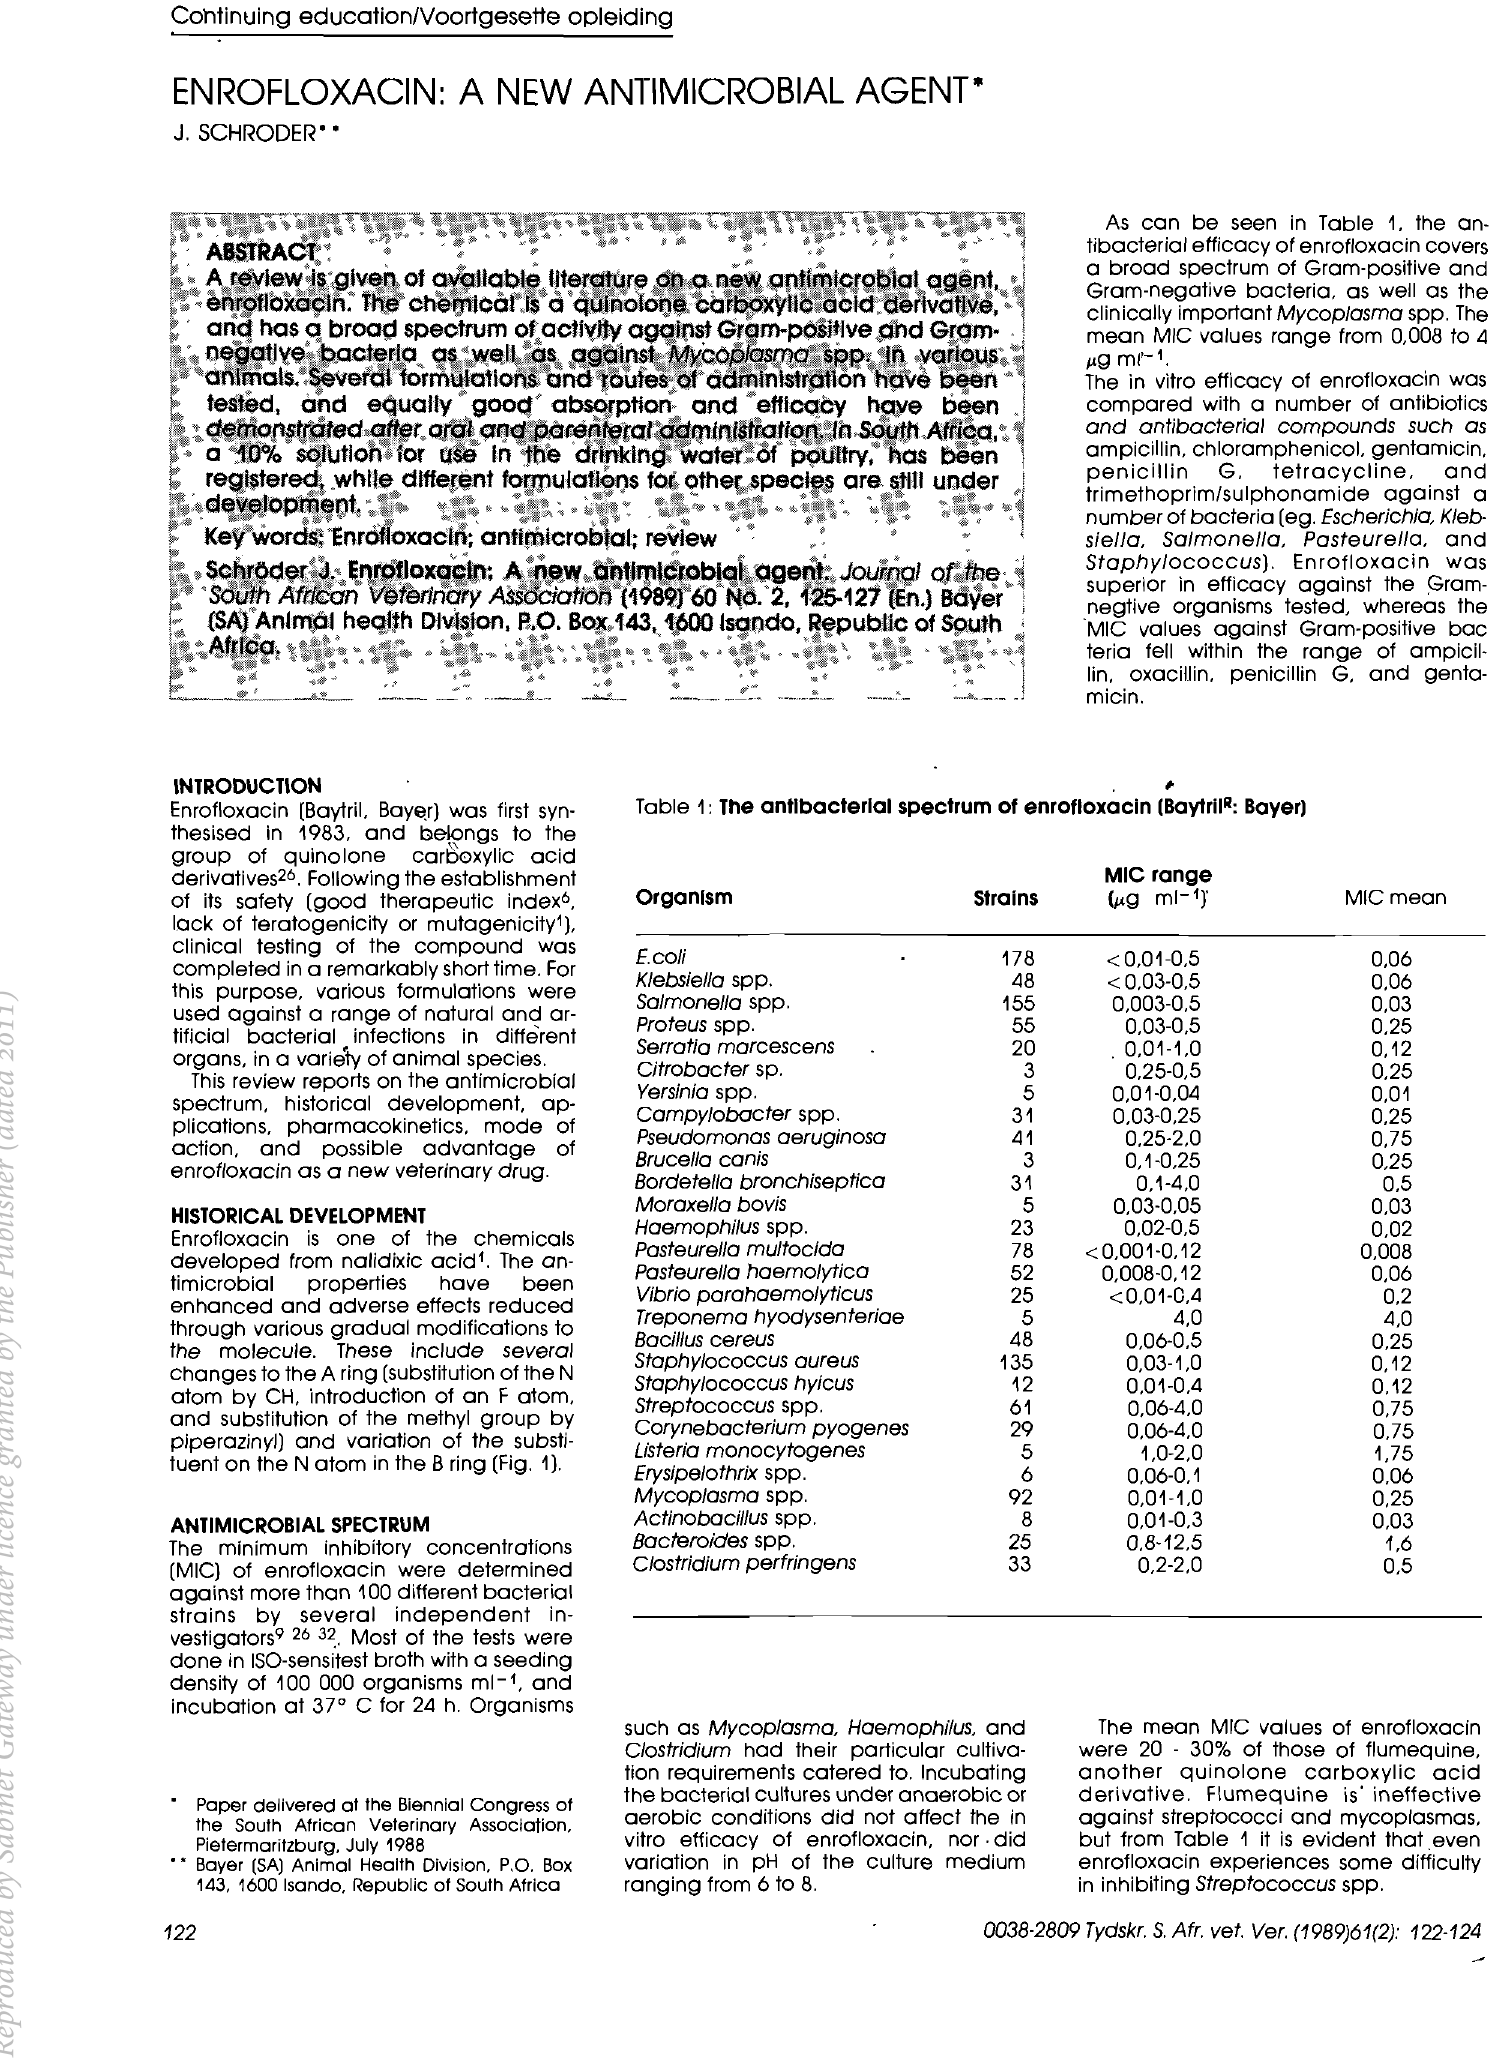
Table 1: The antibacterial spectrum of enrofloxacin (Baytril lil: